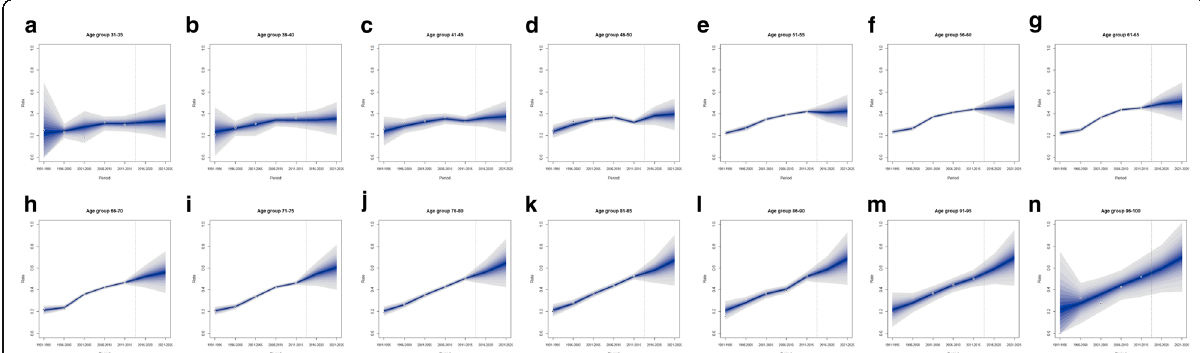
Fig. 4 Pain rates and 10-years pain rate projection per age group in males . a : pain rate projection, males, age 31 – 35. b : pain rate projection, males, age 36 – 40. c : pain rate projection, males, age 41 – 45. d : pain rate projection, males, age 46 – 50. e : pain rate projection, males, age 51 – 55. f : pain rate projection, males, age 56 – 60. g : pain rate projection, males, age 61 – 65. h : pain rate projection, males, age 66 – 70. i : pain rate projection, males, age 71 – 75. j : pain rate projection, males, age 76 – 80. k : pain rate projection, males, age 81 – 85. l : pain rate projection, males, age 86 – 90. m : pain rate projection, males, age 91 – 95. n : pain rate projection, males, age 96 – 100. Note. The predictive mean is shown as solid line. The different shadings indicate pointwise credible intervals. The central interval represents 10% CI, and the largest interval 95% CI. Observed rates are shown as a filled circle. The vertical dashed line indicates where prediction